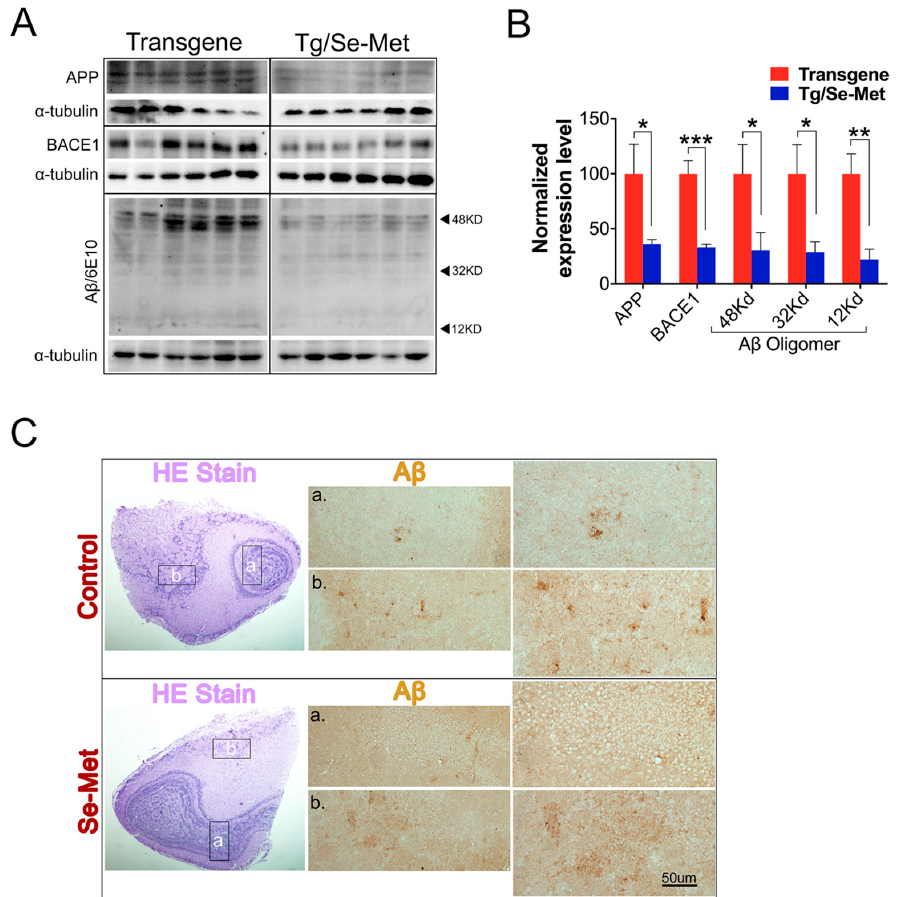
Figure 1. Treatment with Se-Met regulated APP processing by reducing the levels of β -site amyloid precursor protein cleaving enzyme (BACE1) and APP so as to decrease the burden of amyloid production and deposition of A β in the OB of 3× Tg-AD mice. ( A ) The level of full-length APP (fAPP), BACE1, and A β in the OB were detected by western blot; ( B ) Quantitative analysis showed that Se-Met significantly reduced the levels of fAPP, BACE1, and A β oligomers (~12, ~32, and ~48 kD) in the OB of 3× Tg-AD mice. Quantitative results were normalized against the levels of α -tubulin. Values were expressed as percentages in comparison to the control (set to 100%) and presented as the group mean ± SEM ( n = 6). * p < 0.05, ** p < 0.01 *** p < 0.001 vs. the control group; ( C ) Hematoxylin-eosin (HE) staining and immunohistochemical staining using antibody 6E10 revealed that Se-Met had noticeably reduced deposition of A β in all layers of the olfactory bulb (OB) compared with the control mice (a: high magnification images of Gl and Epl layers of OBs; b: high magnification images of MT and Ipl layers of OBs). Scale bars, 50 µm.